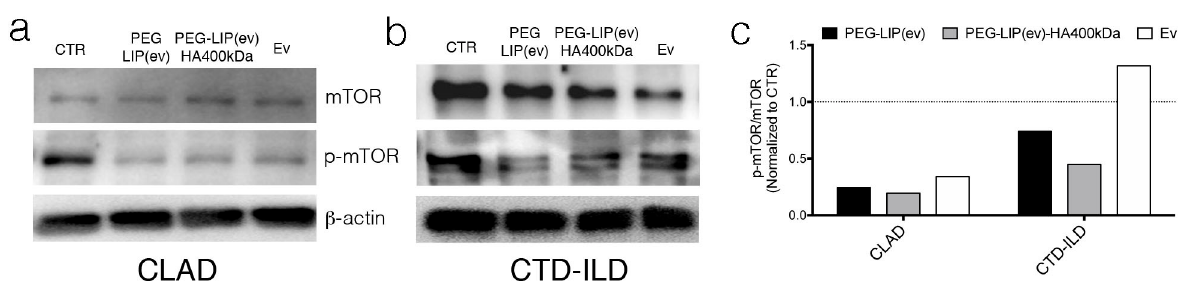
Figure 7. Western blot analysis of mTOR and p-mTOR on LFs derived from ( a ) CLAD and ( b ) CTD-ILD after 24 h of treatment with liposomes and everolimus alone (50 nM). ( a , b ) Representative blot of immunedecoration using anti-mTOR, anti-p-mTOR, and β -actin. ( c ) Quantitative analysis of immunoblots representing the expression level of p-mTOR in CLAD and CTD-ILD normalized to CTR = 1.